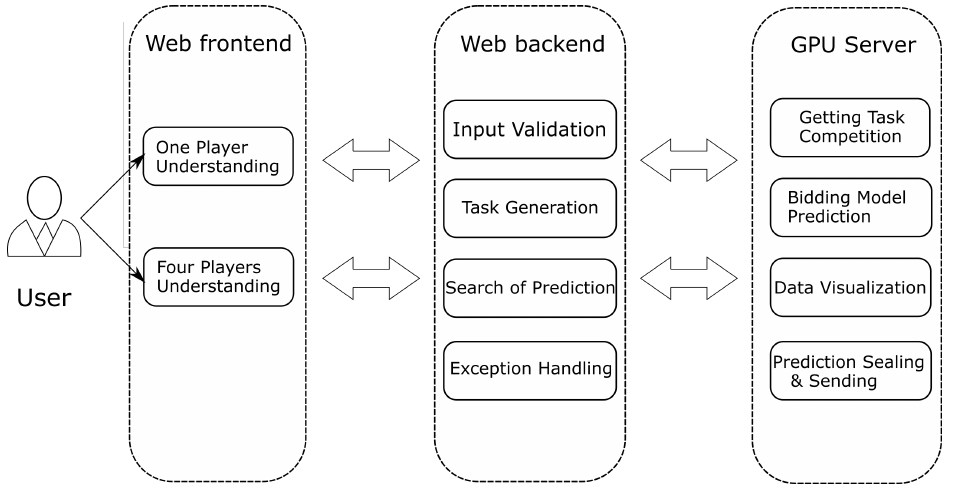
Figure 6. The specific functions of each